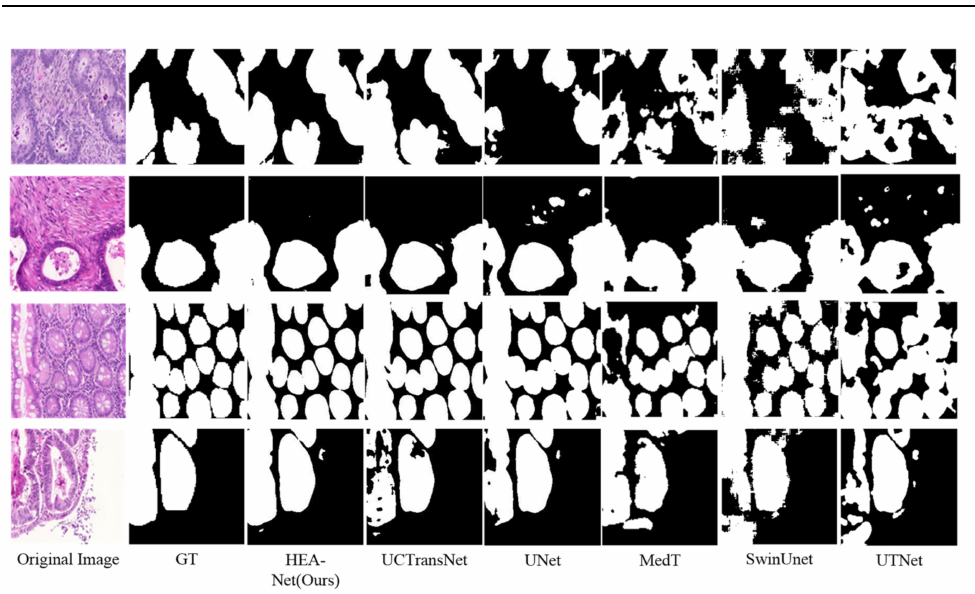
Figure 6. Qualitative results on GlaS